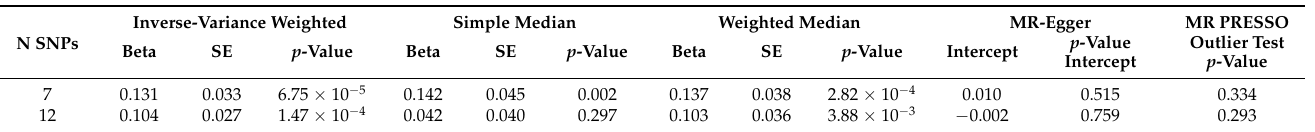
Table 1. Association of genetically predicted non-alcoholic fatty liver disease with blood tyrosine levels across multiple Mendelian randomization methods.